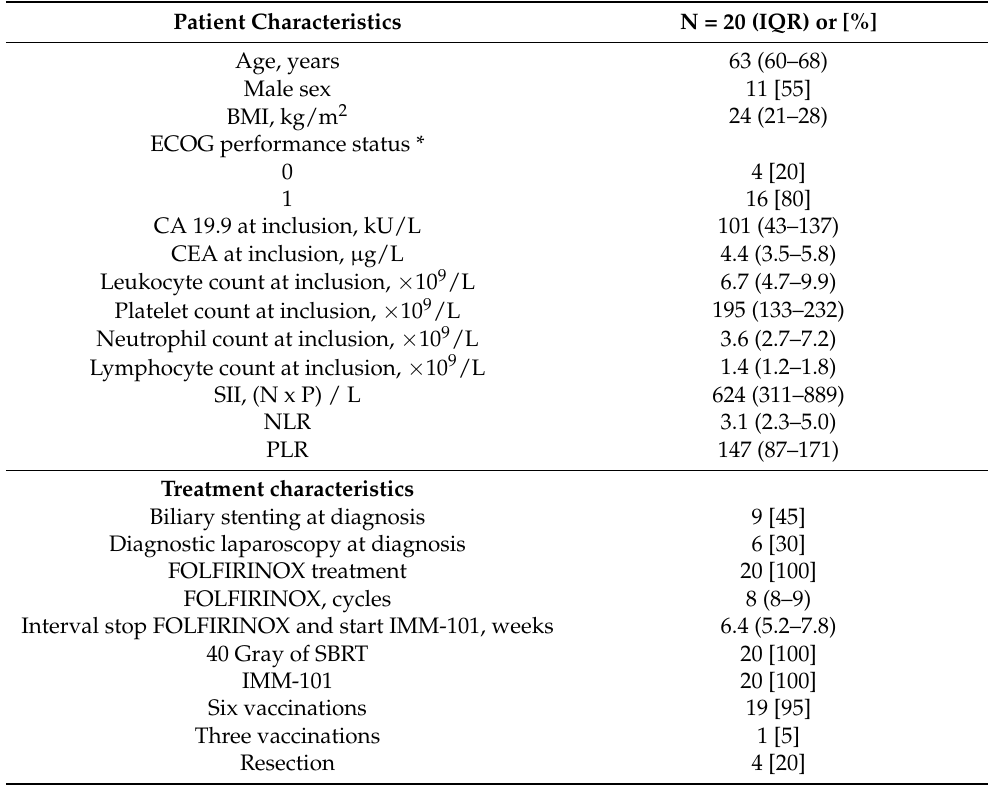
Table 1. Patient and treatment